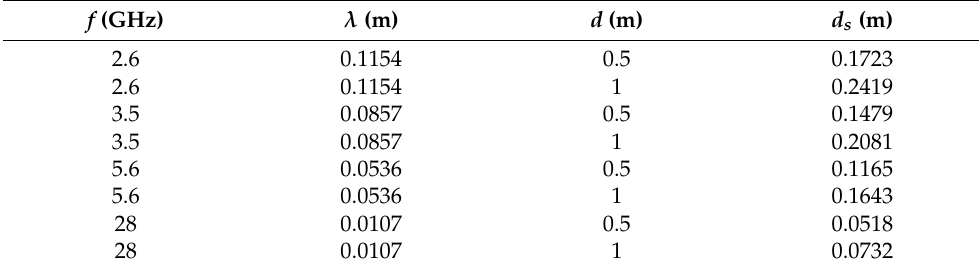
Table 3. Recommendations for 2 × 2 MIMO system of the coupling